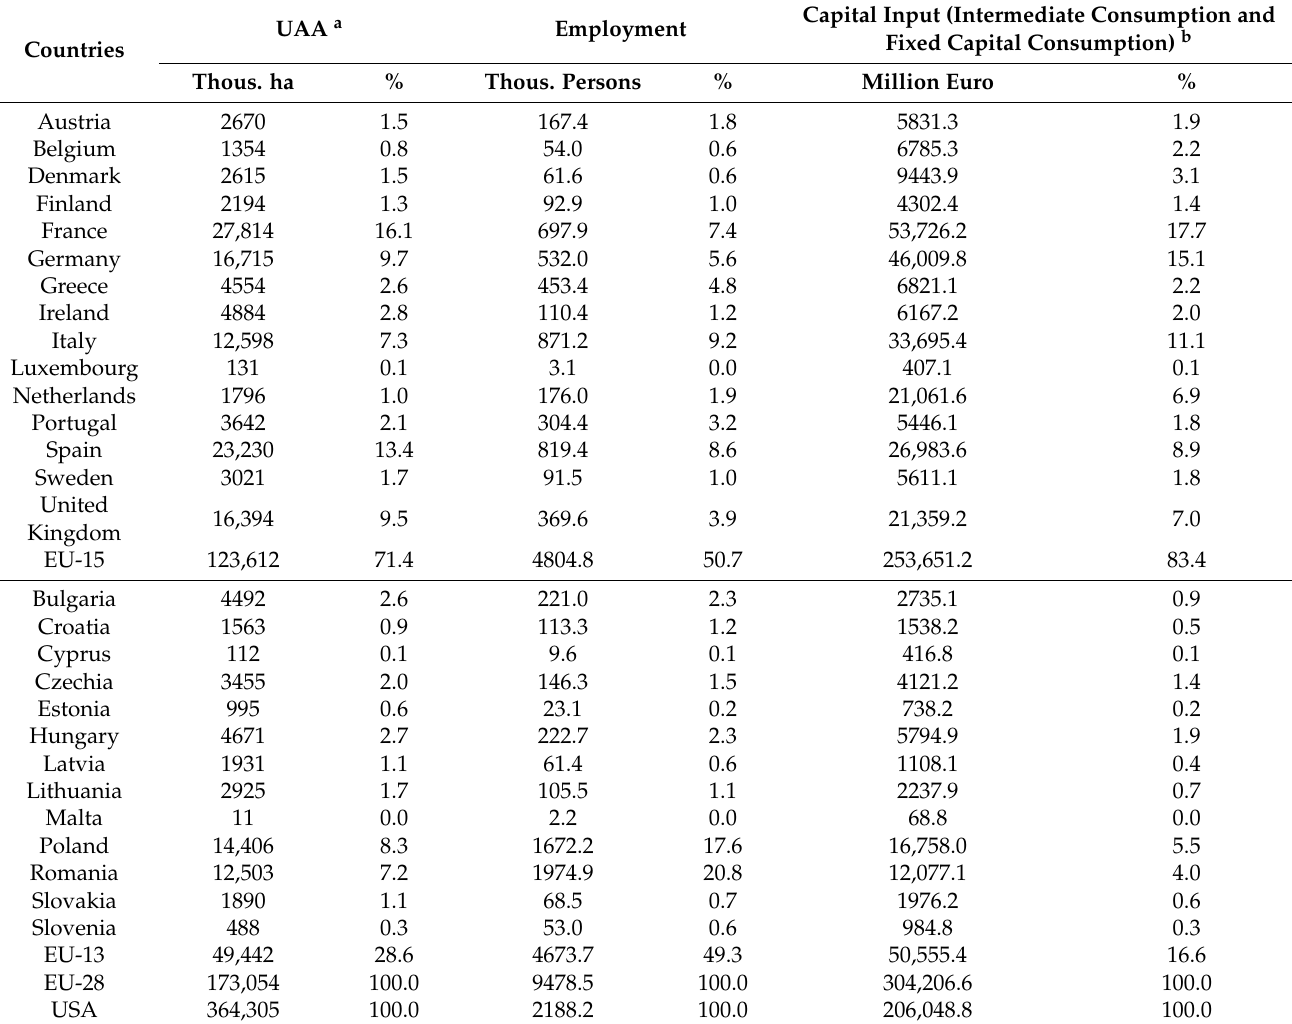
Capital Input (Intermediate Consumption and Fixed Capital Consumption) b